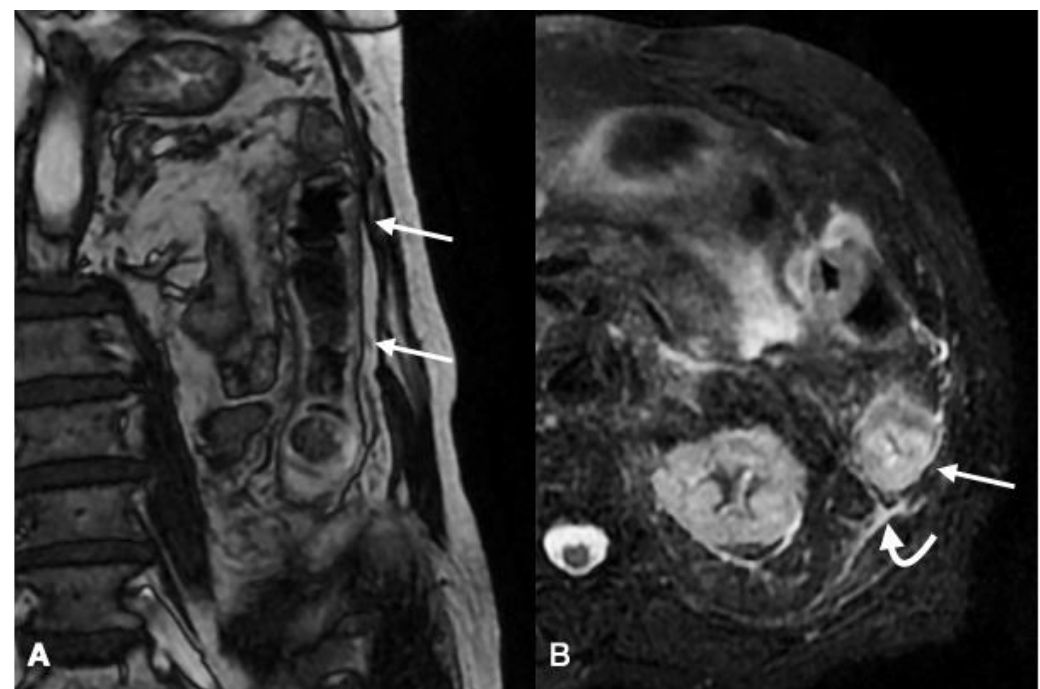
Figure 3. Follow-up MRI in an 80-year-old female with ischemic colitis, ( A ) T2W FIESTA sequence on the coronal plane and ( B ) T2W FatSat sequence on axial plane showing the continuous involvement of the descending colon (( A ), arrows), characterized by oedematous colonic wall thickening (( B ), arrow) with pericolic fluid (( B ), curved arrow).